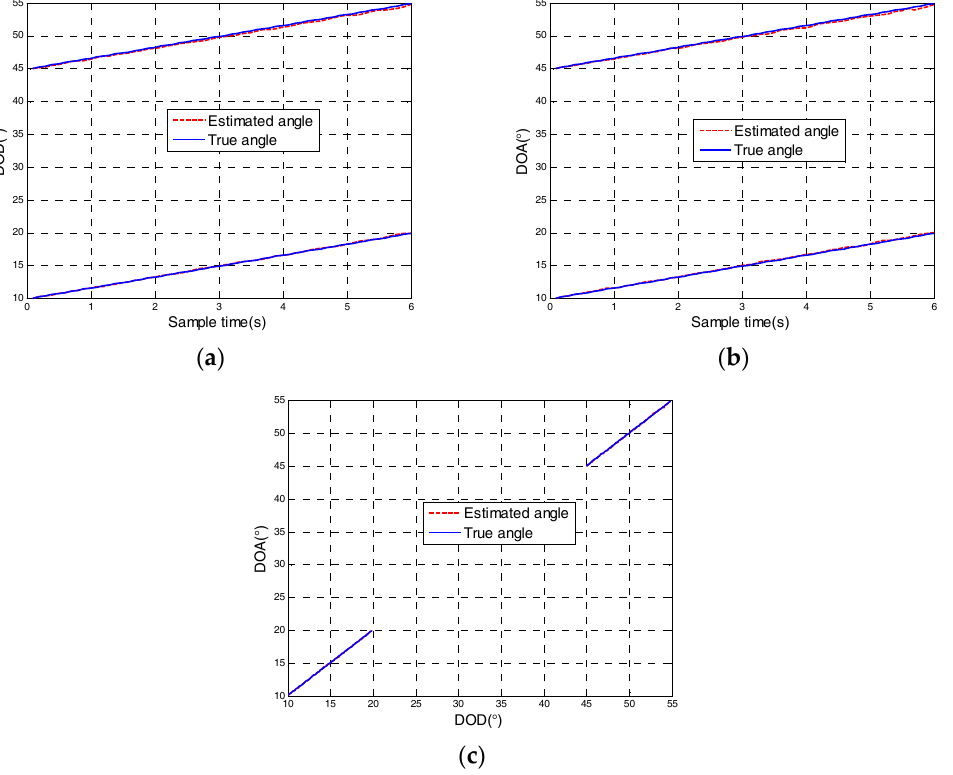
Figure 2. Angle tracking results of uniform moving target at SNR = 15 dB: ( a ) The direction of departure (DOD); ( b ) The direction of arrival (DOA); ( c ) DOD and DOA trajectory.